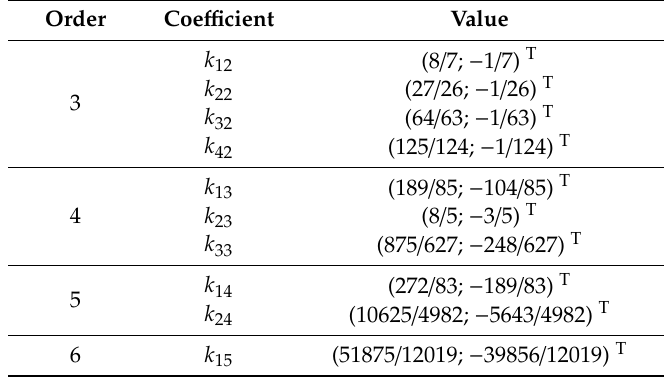
Table 1. Coe ffi cients of the 6th order multistep extrapolation method with 2nd order basic method. Order Coe ffi cient